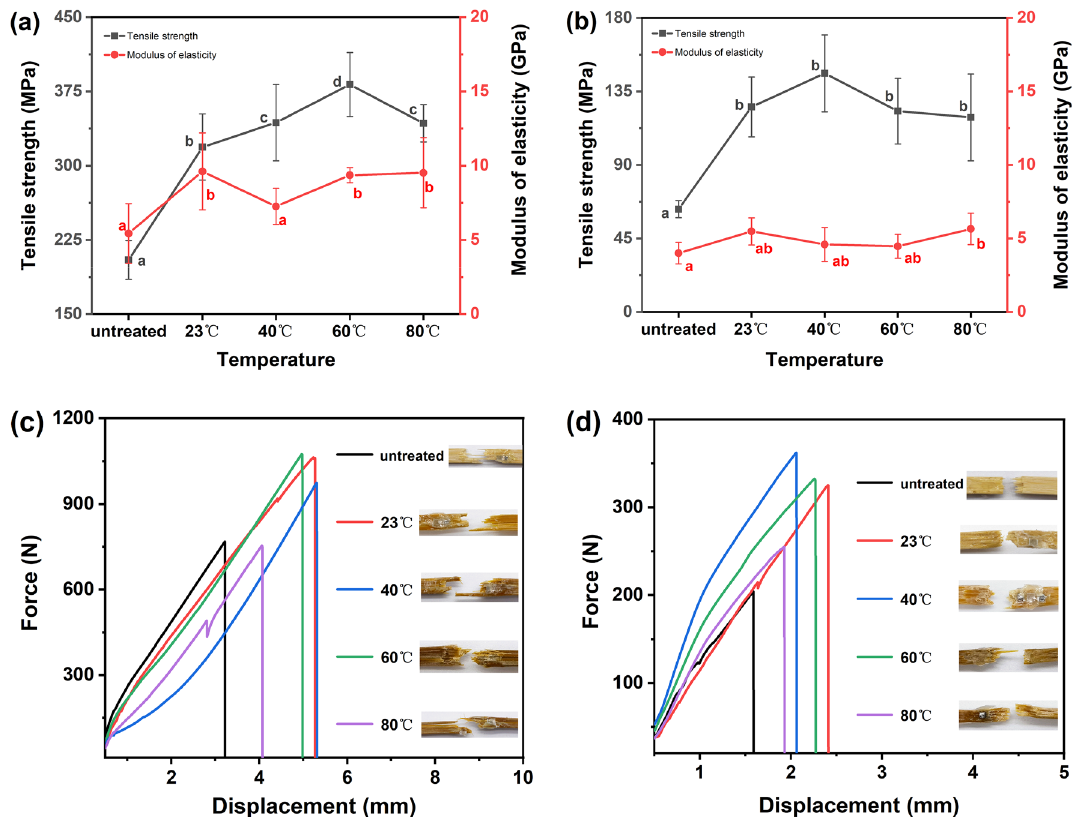
Fig. 6 Tensile properties of bamboo slivers treated with NaOH at different temperatures. a Tensile strength and MOE of outer bamboo slivers; b tensile strength and MOE of inner bamboo slivers; c displacement–load curve and fracture form of outer bamboo slivers; d displacement load curve and fracture form of inner bamboo